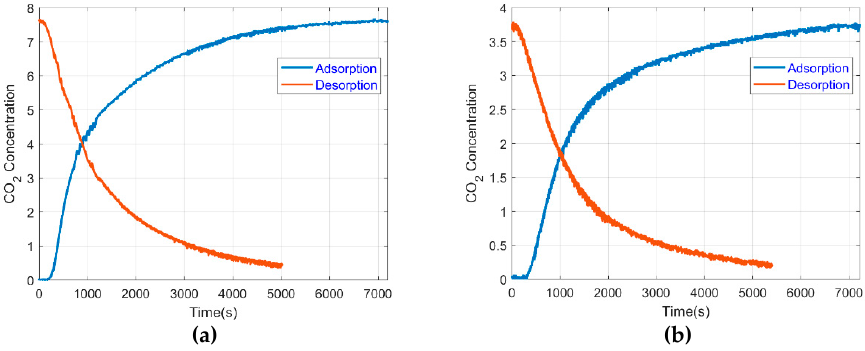
Figure 6. Variation in CO 2 concentration with time during the adsorption and desorption processes for the monocomponent fluidized bed of activated carbon ( a ) Experiment 1; ( b ) Experiment 2.